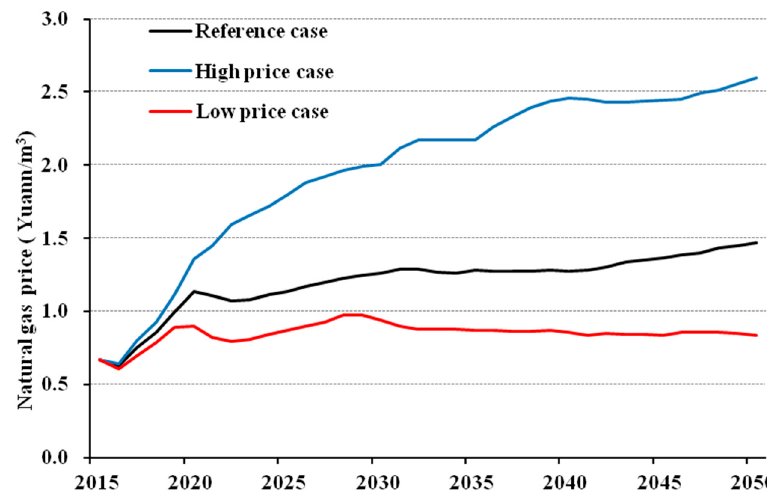
Figure 3. Price scenarios for shale gas (modified from the EIA Annual Energy Outlook 2017).